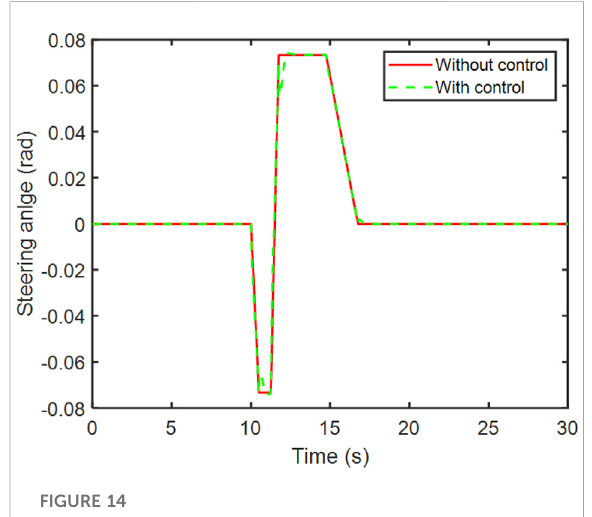
FIGURE 16 Comparison of rear wheel torque.